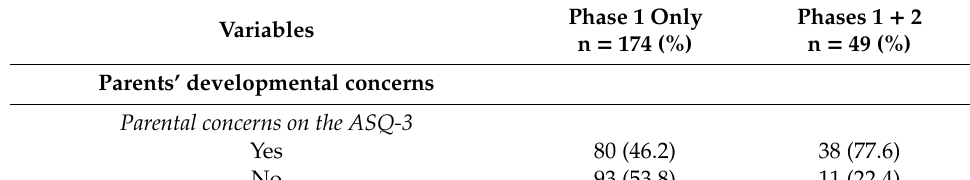
Table 2. Parents’ developmental concerns and reported use of educational, health, and community programs and services.